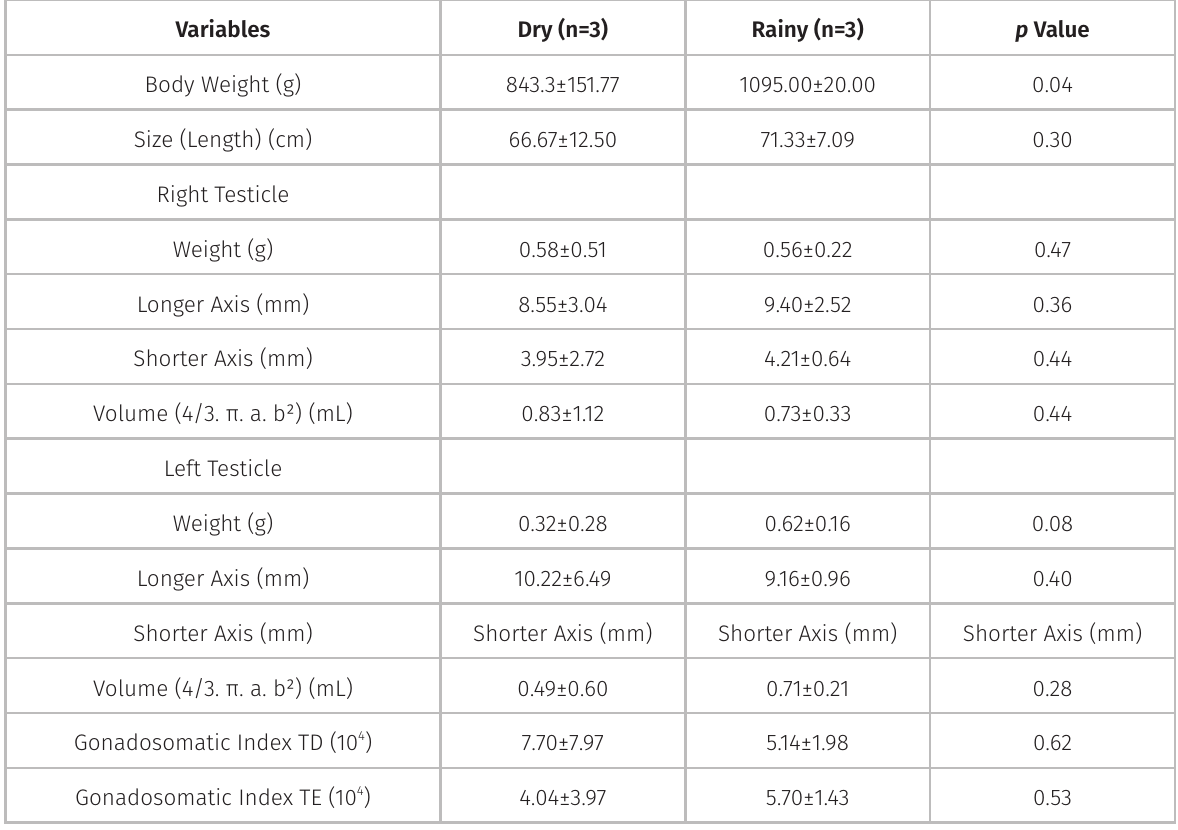
Table I. Body weight (g), body size (length) (cm), weights from the right and left testicles (g), longer axis (mm), shorter axis, volume (mL) and gonadosomatic index from the Ara ararauna right and left testicles between the dry and rainy